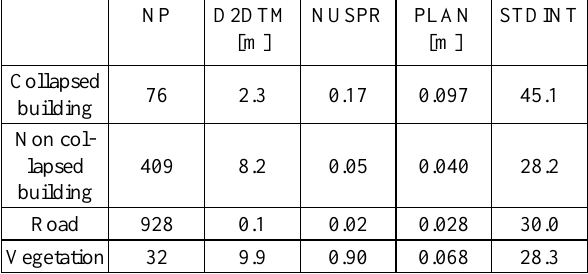
Table 1 Summary of average attribute values in training areas.